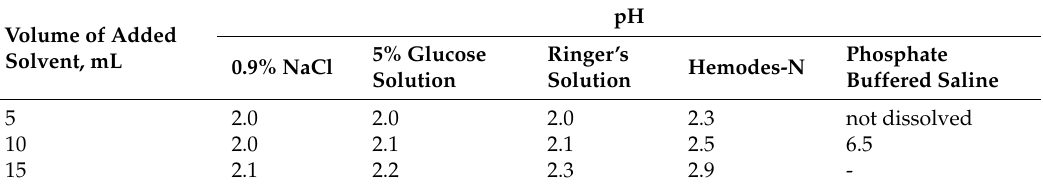
Table 4. Changing of pH by adding various amounts of solvents to lyophilized ormustine PF.